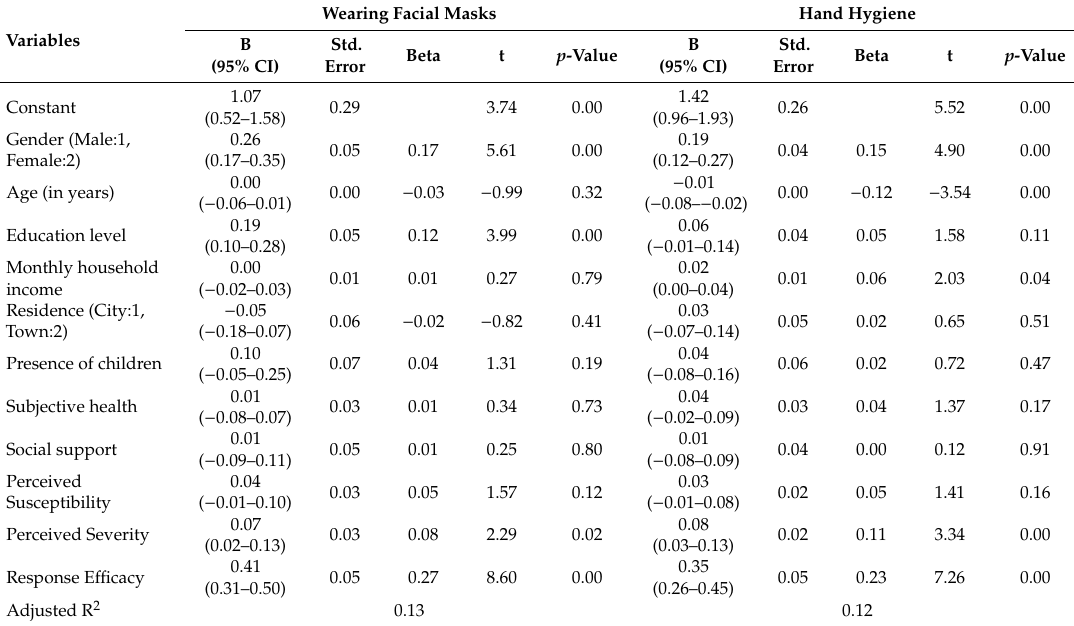
Table 4. Results of multivariate linear regression analysis of precautionary